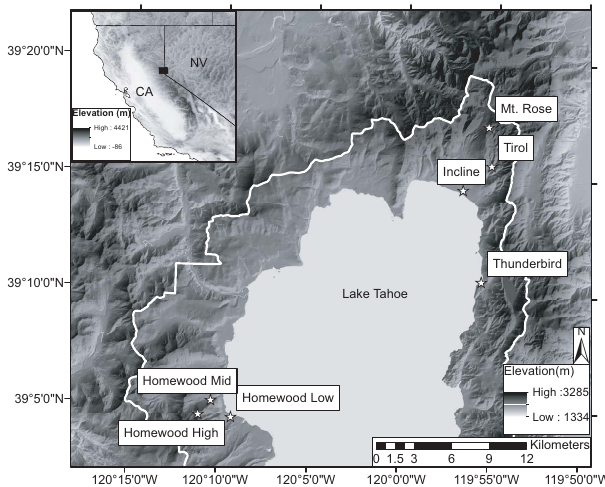
Figure 1. Lake Tahoe watershed map with biweekly sampling sites located along east and west basin elevation gradients for spatial and temporal sampling campaigns in 2011–2012 and 2012–2013. Ad- ditional wet deposition and snow pit profile samples were collected near the Homewood High and Mt. Rose sites during the 2013–2014 snow